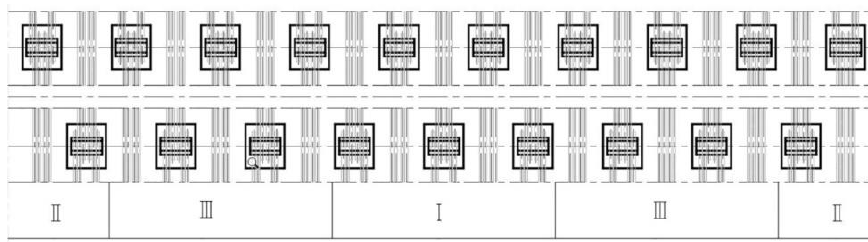
Figure 9. The sequence diagram of tensioning ( Ⅰ - Ⅱ - Ⅲ ). Figure 8. Location of the broken point.